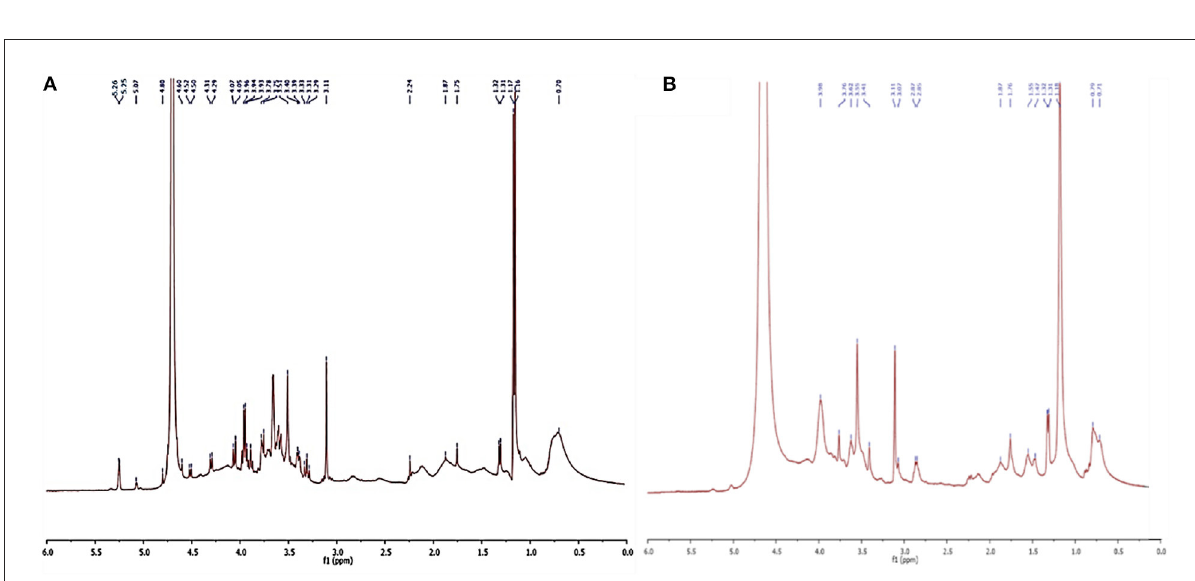
FIGURE5 NMR analysis of biosurfatant produced by L. plantarum ATCC 8014. (A) Biosurfactant from waste-based medium; (B) biosurfactant from MRS broth.